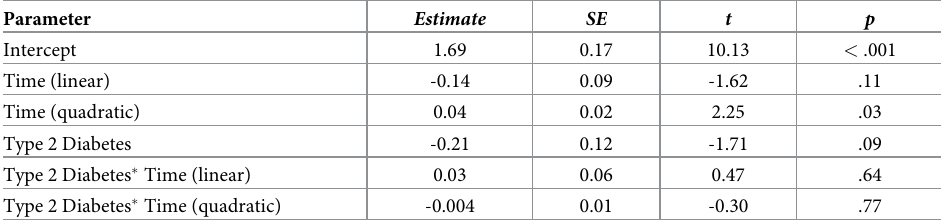
Table 3. Multilevel model on log(HF HRV): Estimates of fixed